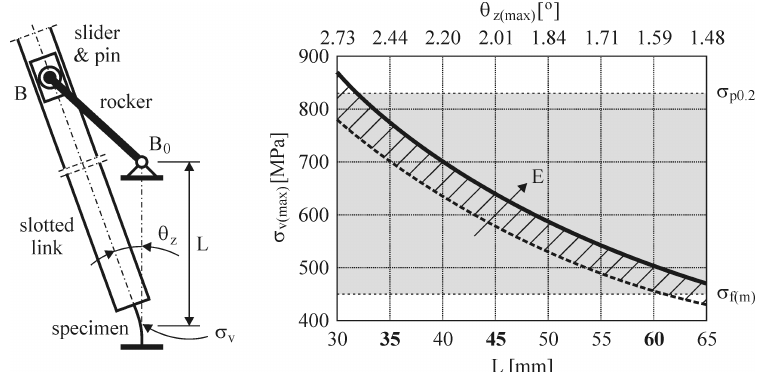
Figure 6. Maximum von Mises stress against the height adjustment of the fatigue test bench and the maximum rotation angle of the flexure hinge specimens (calculated by using a finite element model).